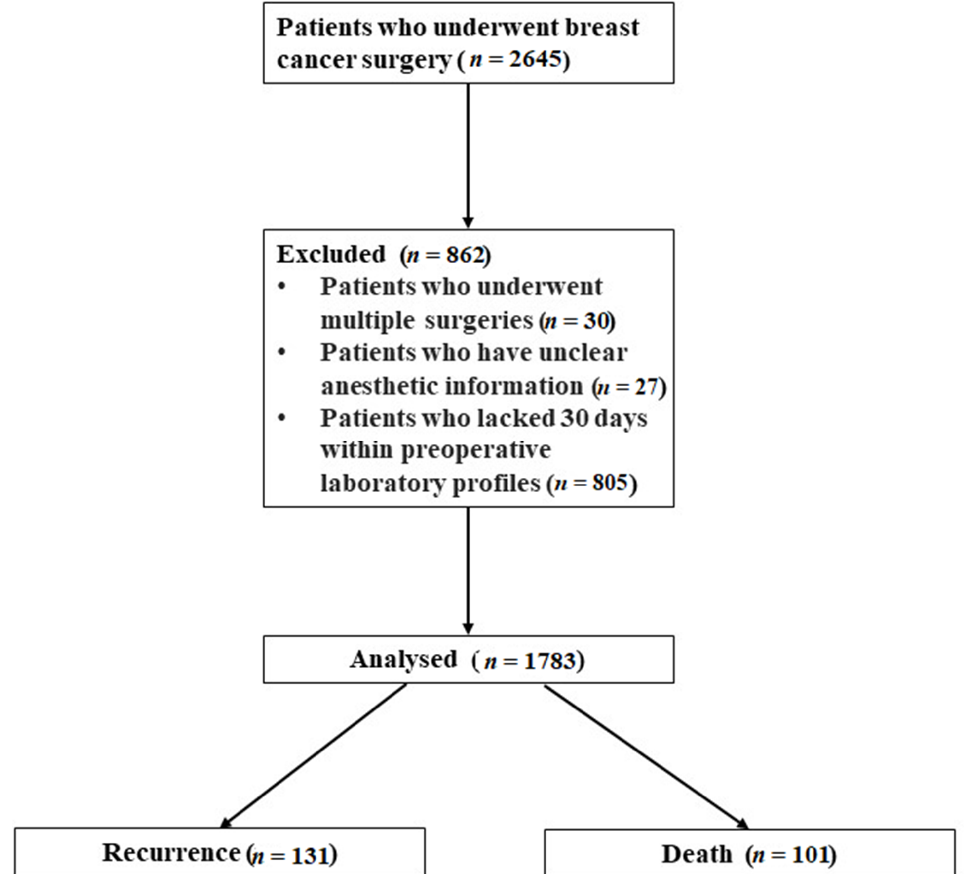
Figure 1. CONSORT Flow Diagram.